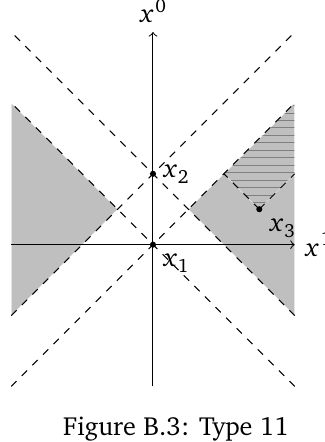
Figure B.3: Type